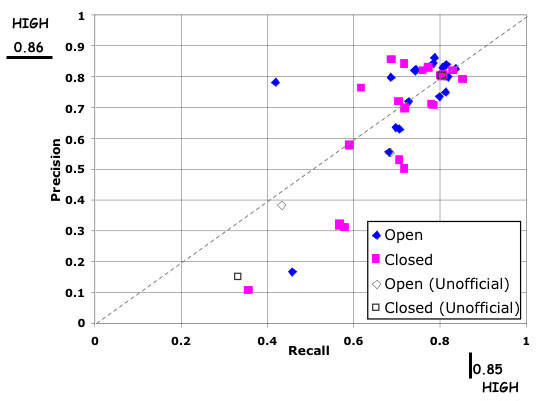
Precision versus recall of the 40+4 submissions.